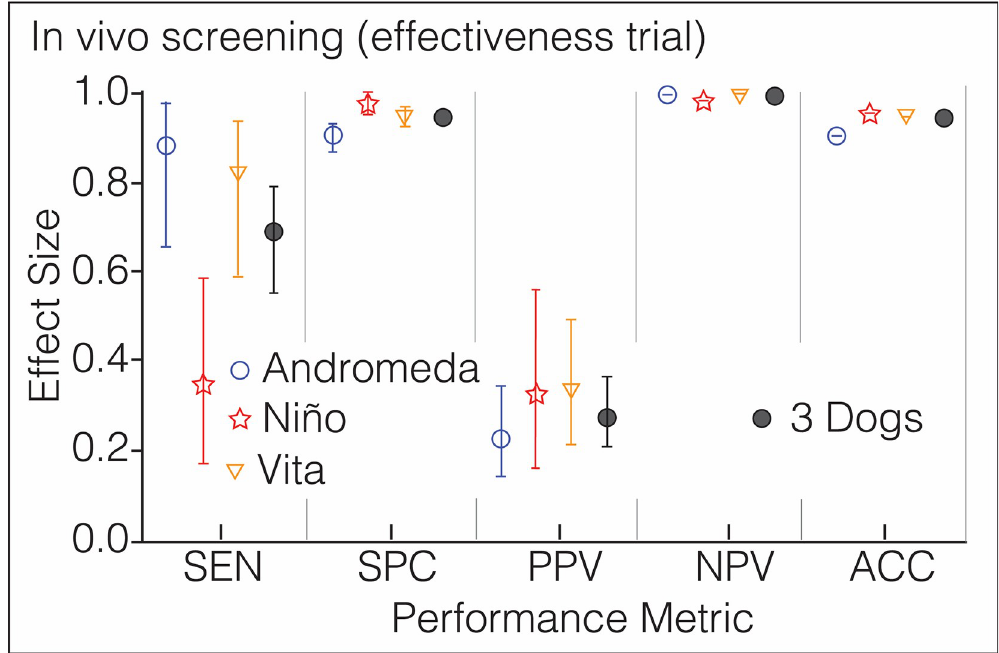
Fig 6. Phase 4: In vivo screening (effectiveness assay). Performance metrics of 3 dogs screening for COVID-19 the citizens riding the Metro System of Medellin; n 550, prevalence 3.1%. Each symbol has a different color to ease visualization of the dogs. The vertical lines above and below the symbols represent the 95% confidence interval for each metric, which is contained within the symbol for NPV and ACC . Additional numeric data in S5 Table in S1 File.